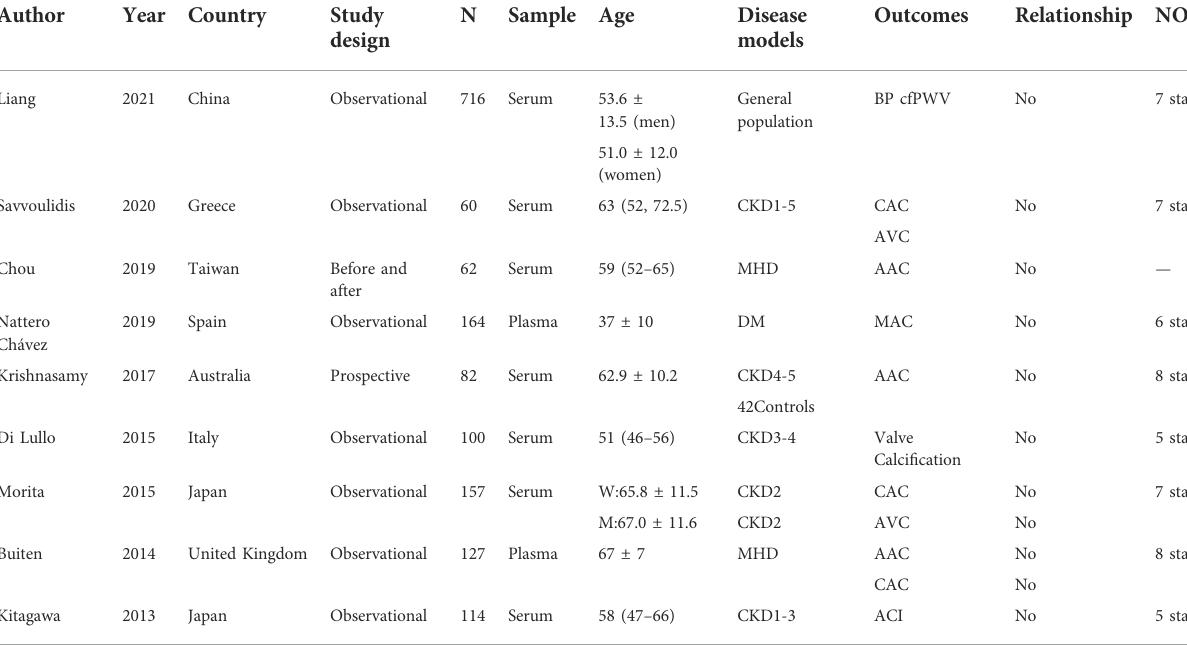
TABLE 4 Characteristics of the negative studies regarding the relationship of Klotho with vascular calci fi cation in CKD